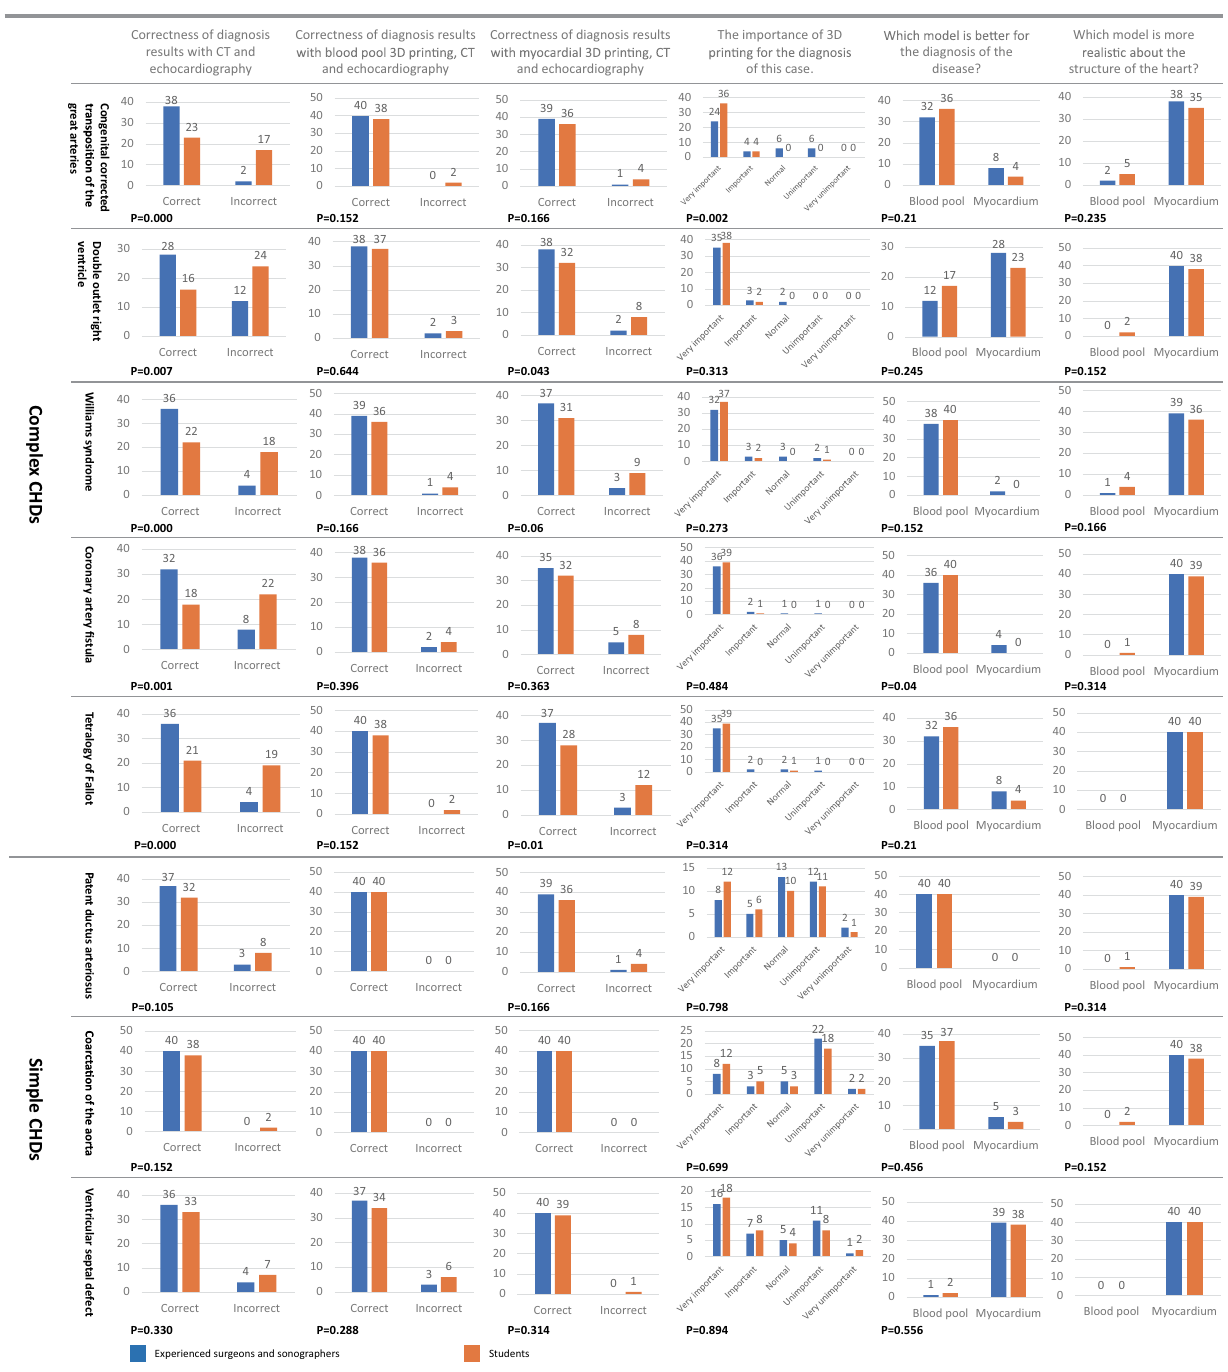
Figure 4. Survey results for eight typical cases between experienced surgeons and sonographers and students. The correctness of diagnosis results with CT and echocardiography, with blood pool 3D prints and echocardiography, and with myocardial 3D prints and echocardiography showed the difference of accuracy under three different diagnostic methods. The importance of 3D printing for the diagnosis of each case showed the demand for 3D printing at different levels, which showed a difference between complex CHDs and simple CHDs. The questionnaire on which model is better for the diagnosis of the disease showed the suitability of the two models for the diagnosis of each case, which differed in different cases. The questionnaire on which model is more realistic about the structure of the heart showed the similarity of two different models with heart, myocardial 3D printing is generally considered to be more similar to the actual